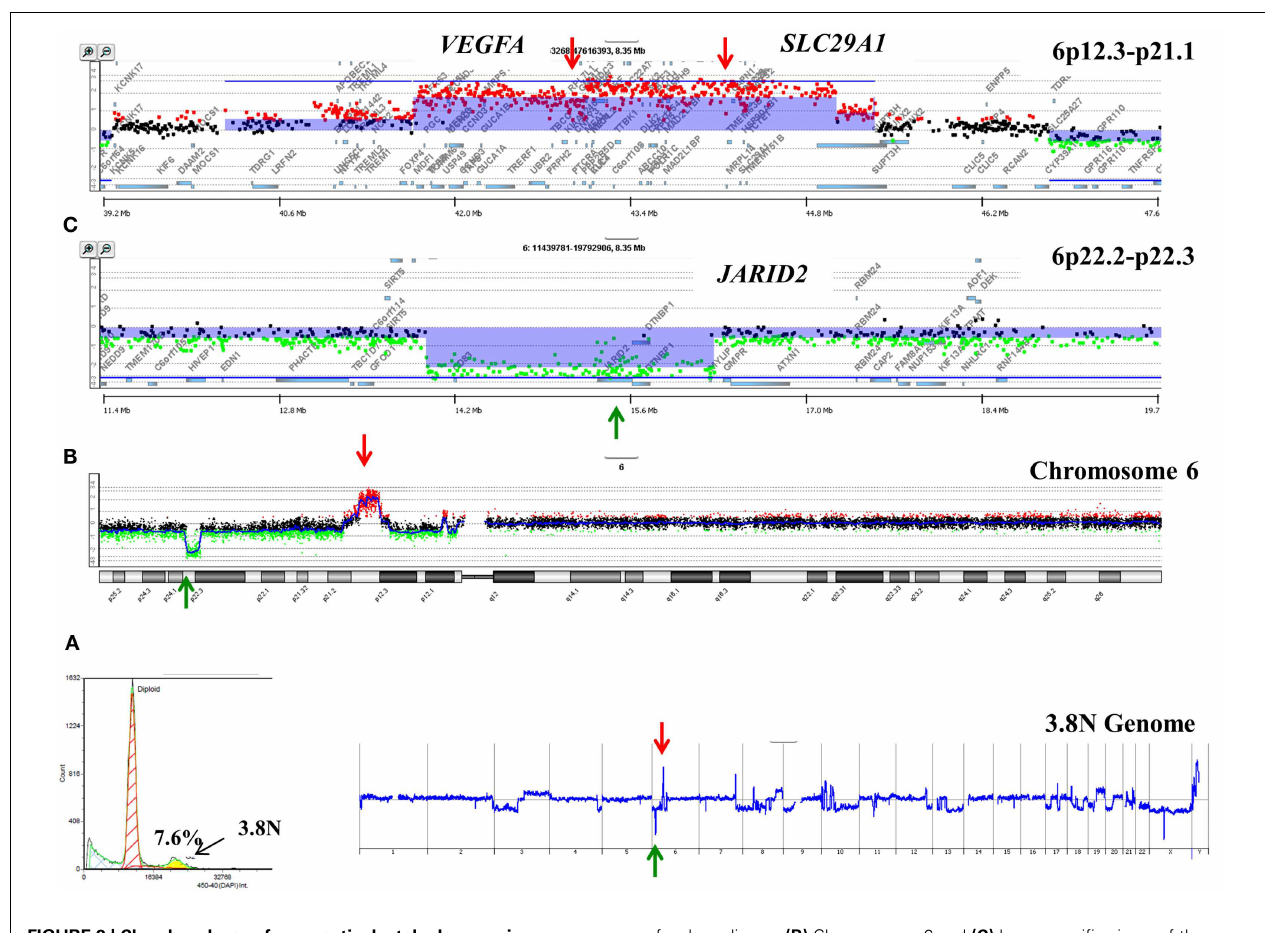
FIGURE 2 | Clonal analyses of pancreatic ductal adenocarcinoma (PDA) biopsy P1026Z. (A) DAPI-based DNA content analysis detected a 3.7N population representing 7.6% of the cellular content of the biopsy. Only the 3.7N population showed homozygous deletions and